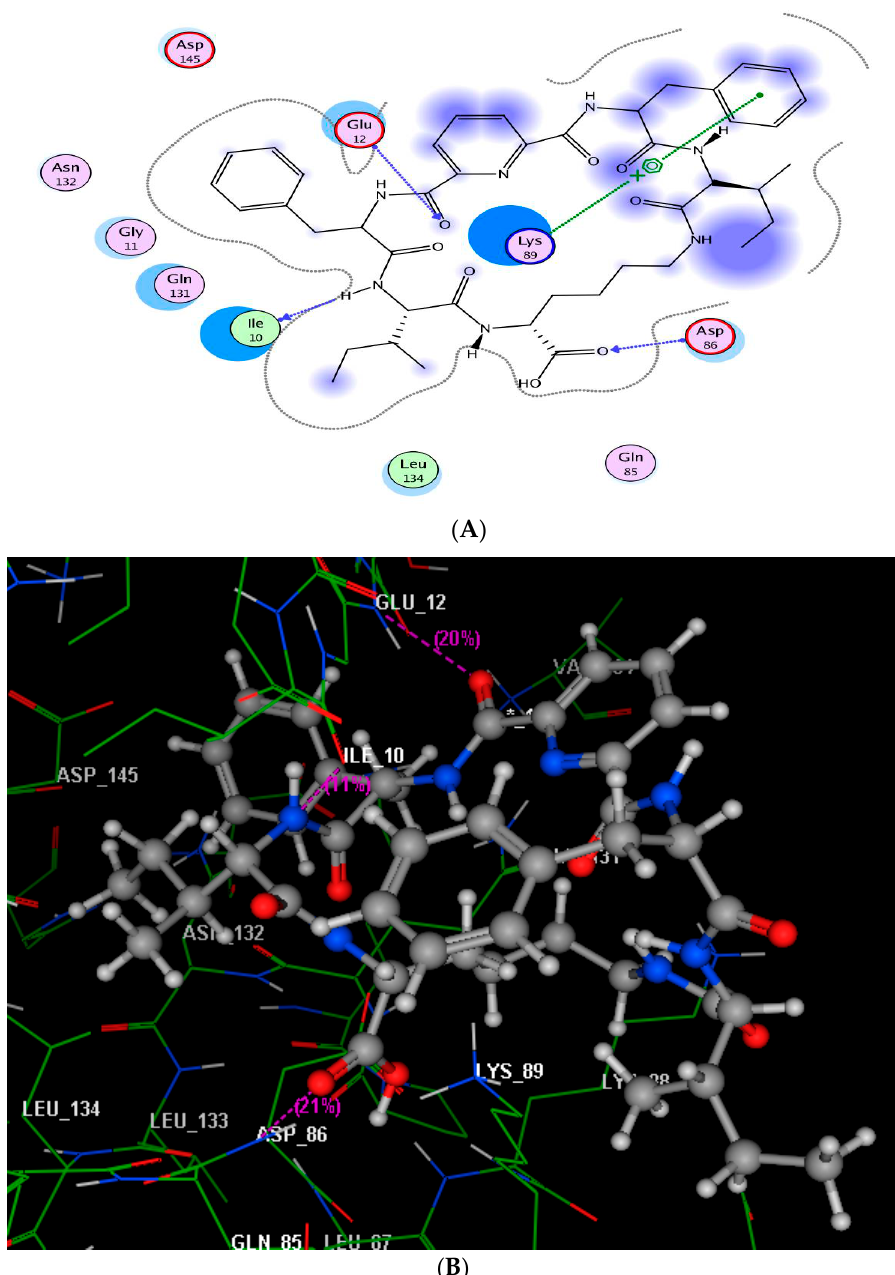
Figure 6. Docking solution for 5c in the active site of CDK-2; ( A , B ) showing 2D and 3D ligand-receptor interactions (hydrogen bonds are illustrated as arrows; C atoms are colored gray, N blue and O red).